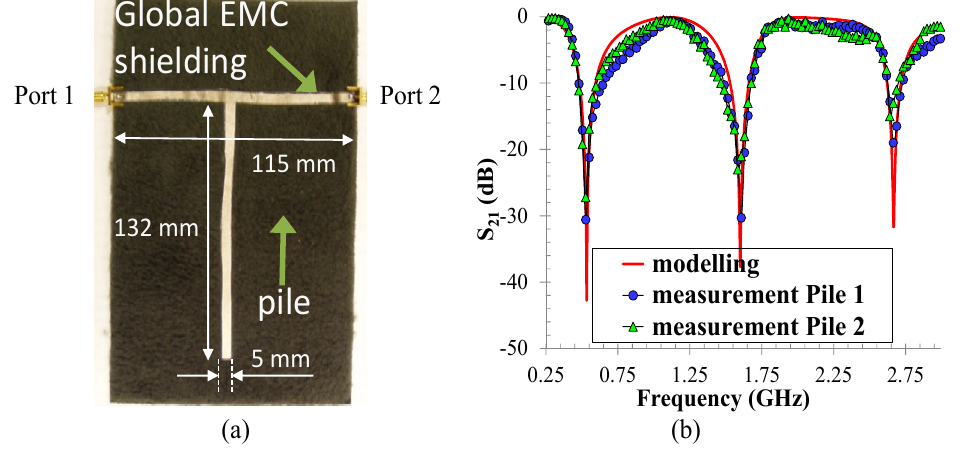
Figure 1. ( a ) Photo of the wearable T-resonator prototype. ( b ) Measured and simulated transmission coefficient behavior vs.